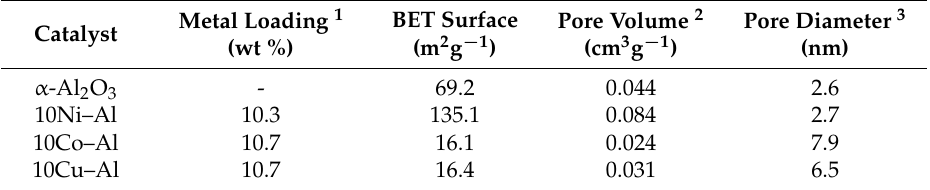
Figure 2. Nitrogen adsorption/desorption isotherms of ( a ) 10Ni–Al, ( b ) 10Co–Al ( c ) 10Cu–Al and ( d ) Al 2 O 3 calcined sample. Table 1. Physico-chemical of the calcined samples.